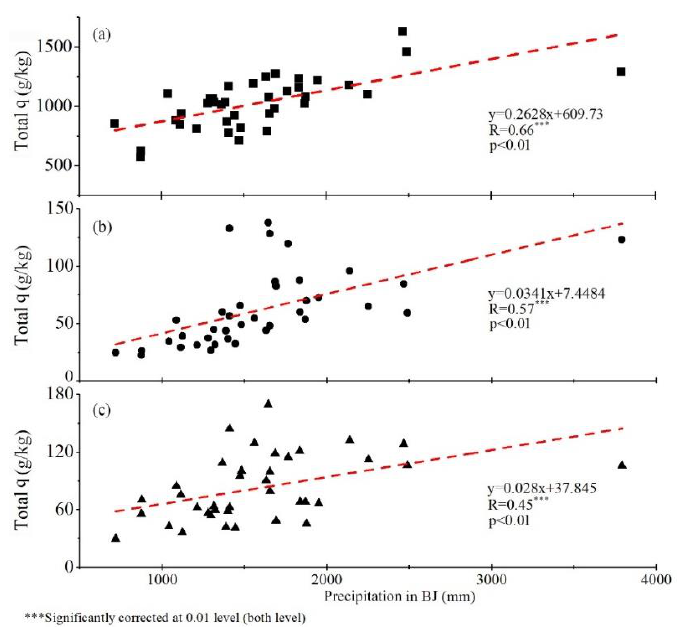
Figure 10. Scatter plot of precipitation in Northern Xinjiang at 28 sites versus total q (g / kg) in the WE ( a ), SB ( b ), and NP ( c ).